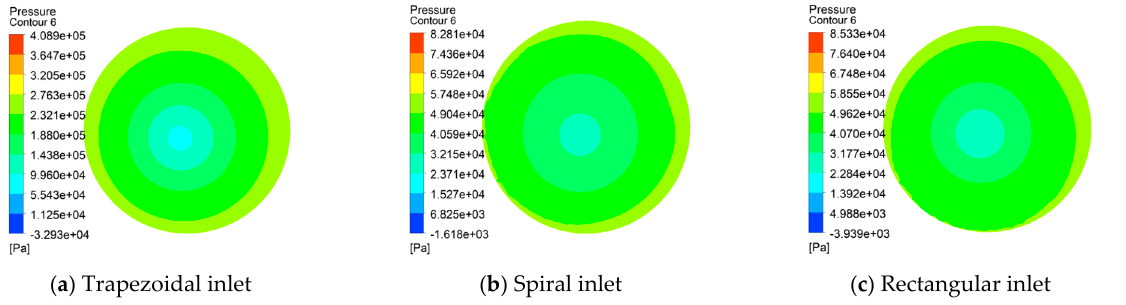
Figure 7. Pressure distribution nephogram of section Z.